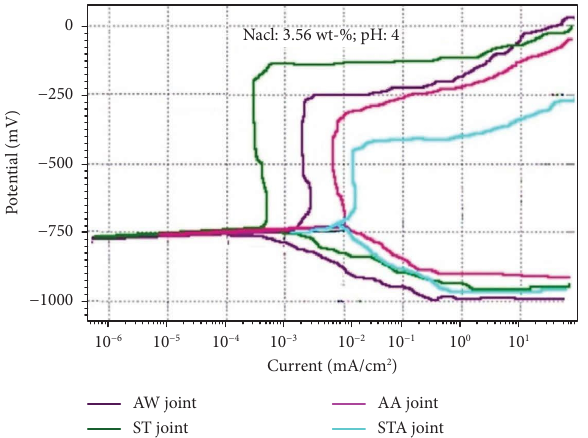
Figure 11: Tafel plot of welded joints in 3.56wt.% NaCl solution having a pH of